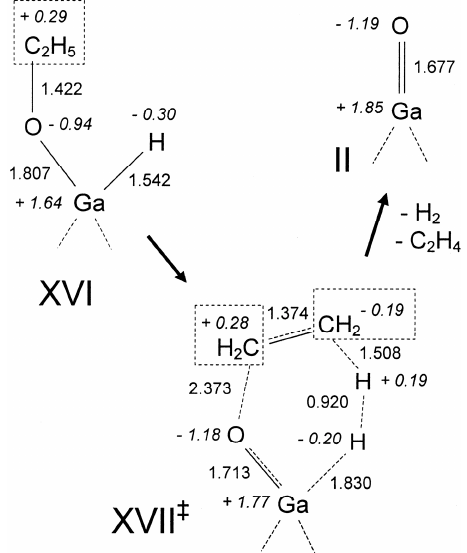
Figure 11. Regeneration of the adsorbed gallyl ion after “carbenium” activation of ethane. Reprinted with permission from ref [117]. Copyright 2000 American Chemical Society.